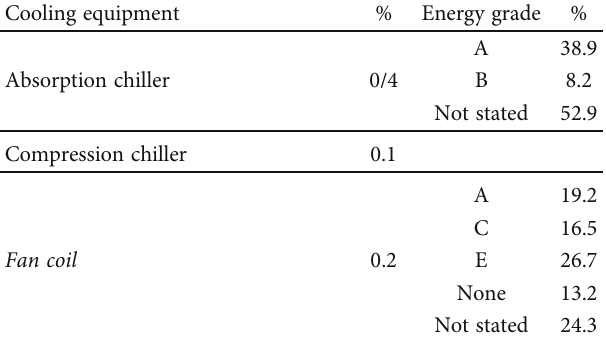
Refrigeration package